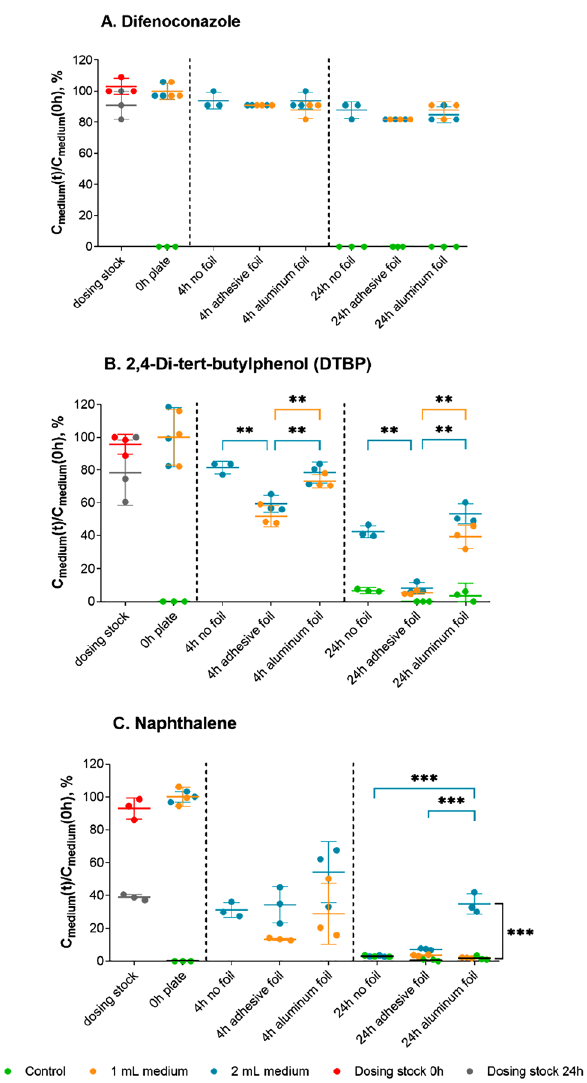
Figure 2. Impact of the covering method on losses of chemicals with different volatility. On the y-axes, the chemical concentration measured in the exposure medium at time t is shown as the percentage of the concentration at time point 0 h. ( A ) non-volatile, hydrophobic (logHLC = − 11.05, logK OW = 4.3) difenoconazole, ( B ) semi-volatile, hydrophobic (logHLC = − 5.43, logK OW = 5.19) 2,4-di-tert-butylphenol, ( C ) volatile, less hydrophobic (logHLC = − 3.36, logK OW = 3.3) naphthalene. Stars represent significantly different groups according to two-way ANOVA and the Tukey test (**0.001 ≤ p < 0.01, ***p <